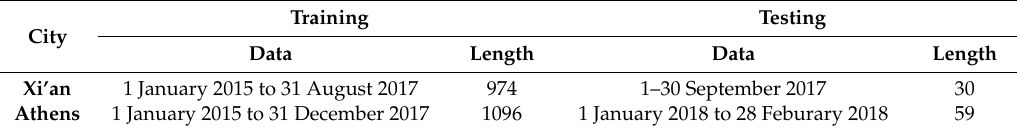
Table 2. The arrangement of data in the training and testing process.